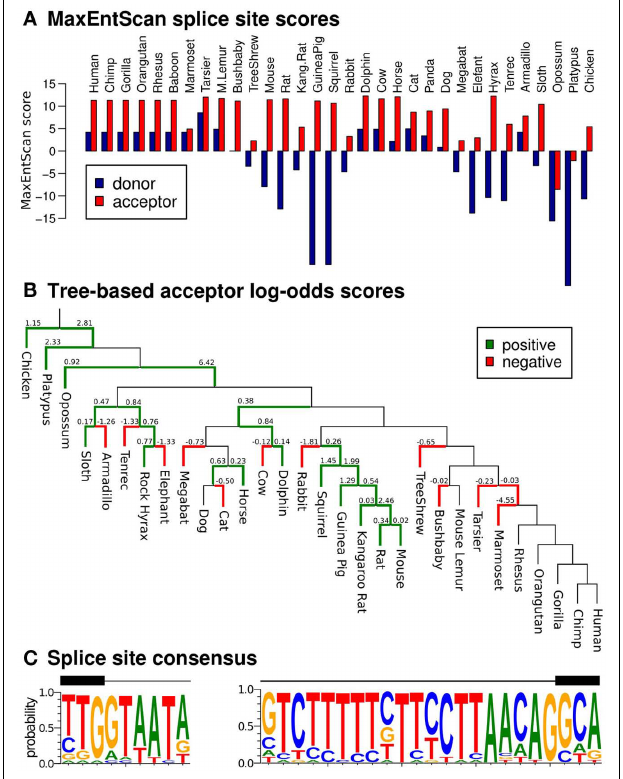
FIGURE 4 | Splice site conservation. We evaluated the similarity of our splice site candidates to real splice sites using MaxEntScan (Yeo and Burge, 2004) and a novel log-odds scoring scheme that also takes phylogenetic information into account (Rose et al., 2011). (A) Draft genomes like hyrax or tenrec as well as genomes with additional insertions compared to human, such as mouse or rat, exhibit a weak MaxEntScan donor signal. However, the majority (75%) of tested splice sites (46/64) are likely real according to MaxEntScan. (B) Evolutionary traces of substitutions at EGO-B acceptors. Green edges indicate substitution events that are in agreement to real splice sites, red edges indicate unusual substitution patterns. (C) Sequence logos for the putative donor (left) and acceptor sites